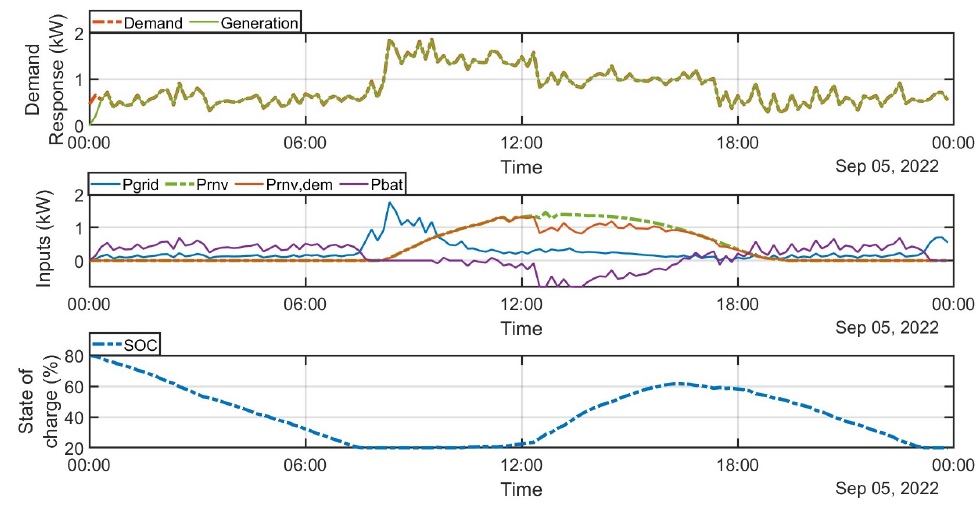
Figure 5. Demand response and battery SOC.